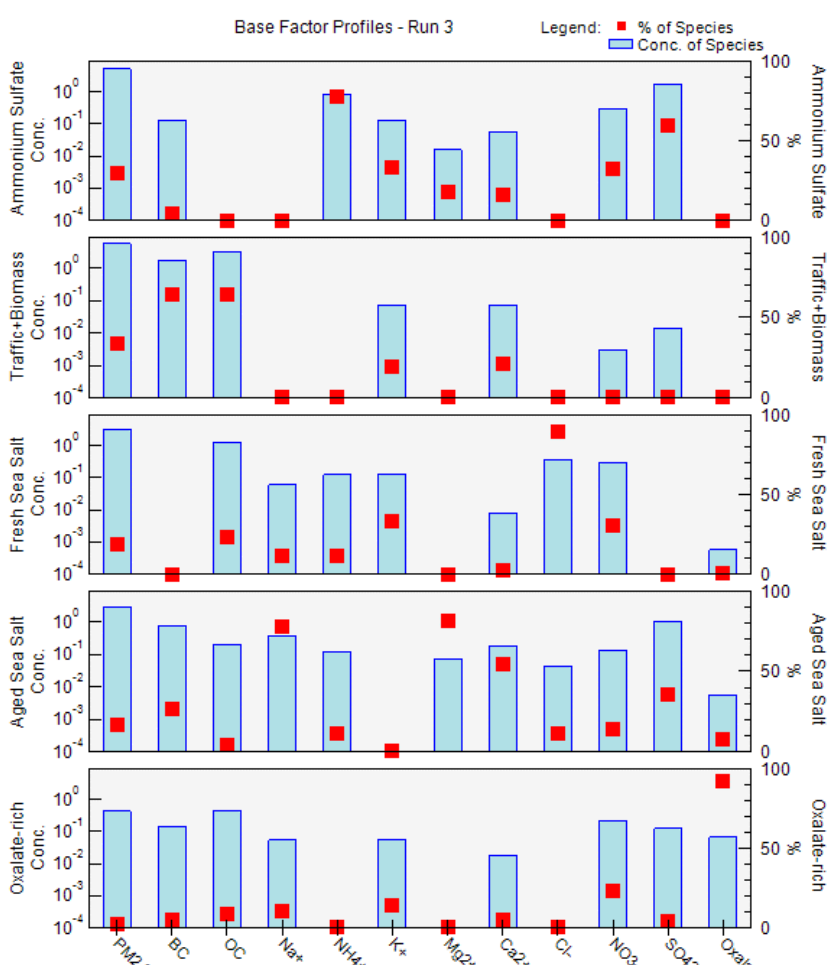
Figure 4. PM 2.5 factor profiles obtained by PMF model using the BC, OC, and chemical concentrations in Tetouan for the 2011–2012 period. Blue bars show the normalized concentration of the species ( µ g/m 3 ) in the factor, while the red dots show the percentage of that species in the factor.